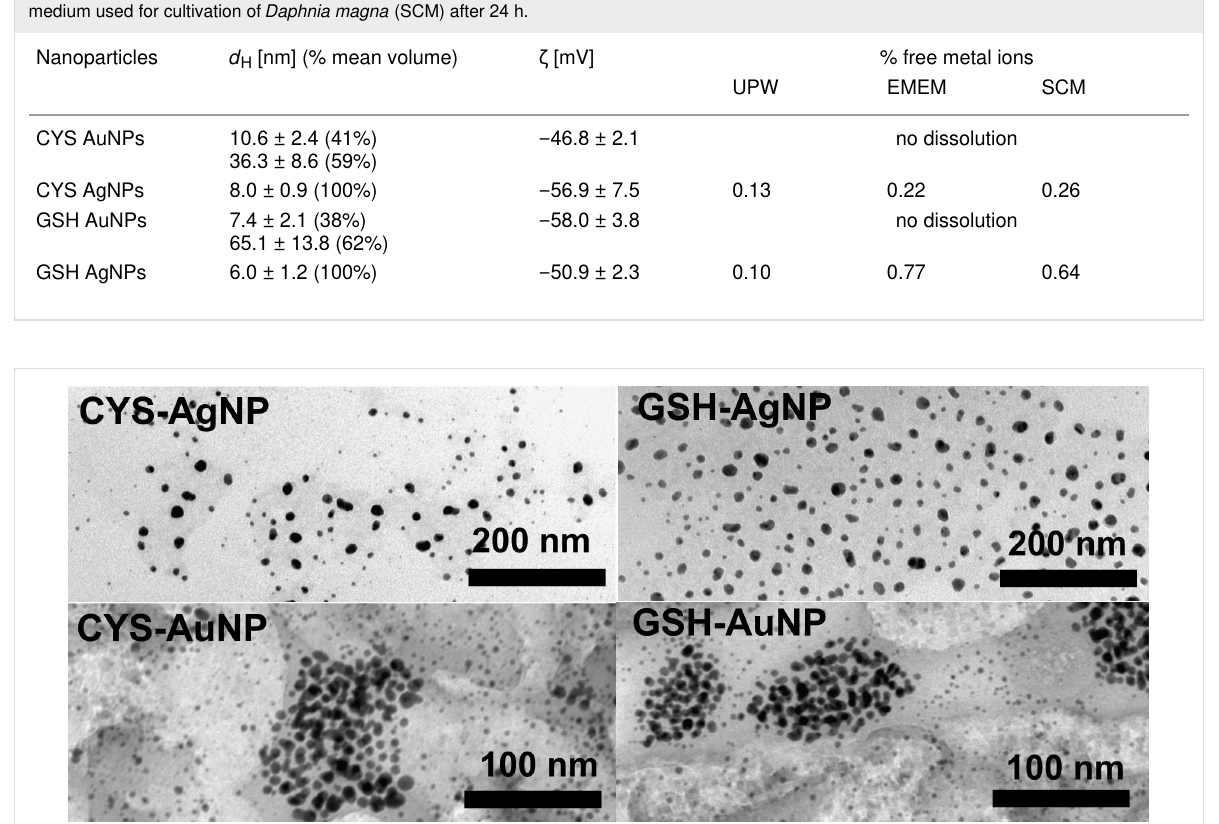
Table 1: Hydrodynamic diameter ( d H ) and zeta potential ( ζ ) of silver (AgNPs) and gold (AuNPs) nanoparticles stabilized with cysteine (CYS) or glutathione (GSH). The dissolution behavior was evaluated in ultrapure water (UPW), the cell culture medium used for L929 cells (EMEM) and the medium used for cultivation of Daphnia magna (SCM) after 24 h.